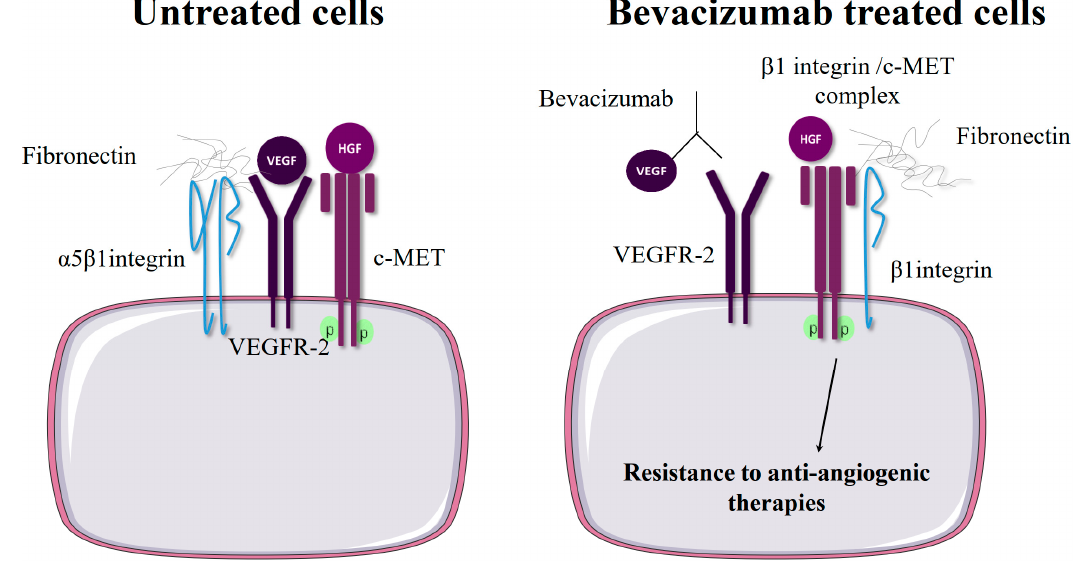
Figure 2. Hypothetical model presenting how β 1/c-MET molecular complexes provide cancer cell resistance to anti-angiogenic therapies. In untreated cells, ligand-activated VEGFR-2 engages both α 5 β 1 integrin and c-MET, impeding their physical contact. In α 5 β 1 integrin-expressing cells, anti-angiogenic therapeutic intervention with bevacizumab decreases VEGF / VEGFR-2 binding. β 1 / c-MET complex formation is thus promoted, which leads to the cross-activation of both receptors and the activation of the downstream AKT signaling pathway (adapted from [18]).